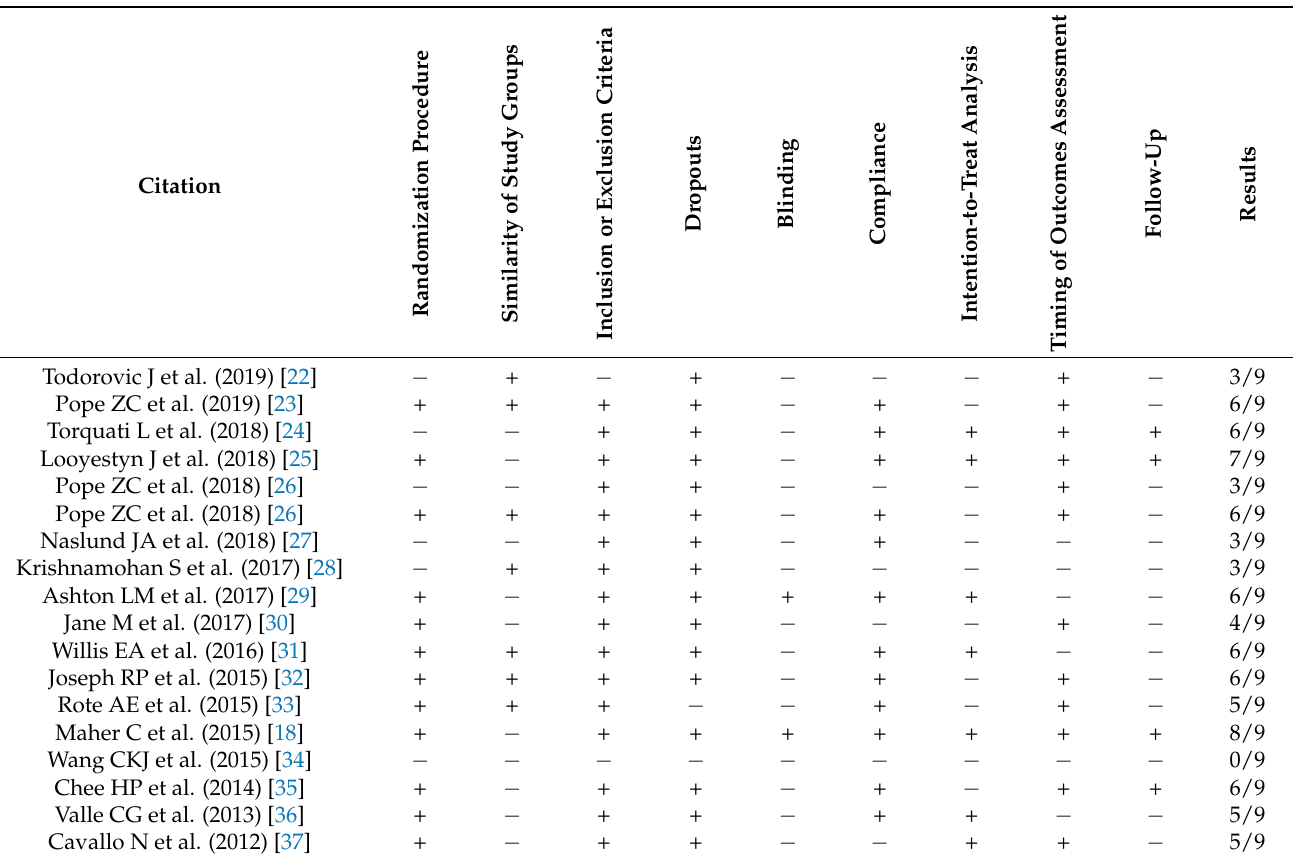
Table 2. Quality assessment of the included